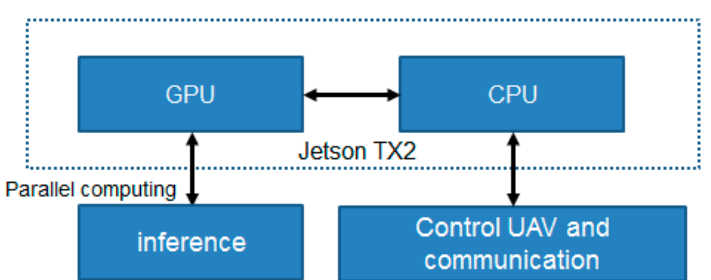
Figure 4. Task assignment on the Jetson TX2 module.